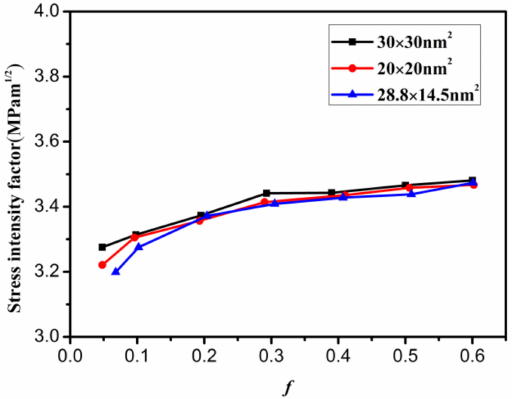
Figure 8. The influence of crack proportion f on the mode I critical stress intensity factor in di ff erent graphene models.